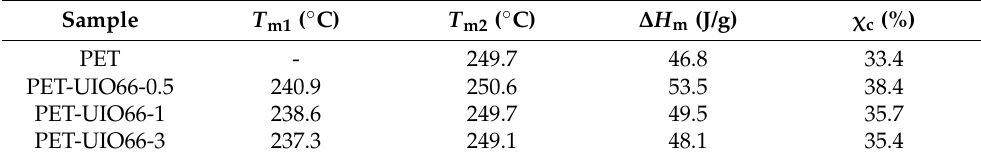
Figure 4. Second heating scans of the PET and the PET/UIO-66 nanocomposites. Table 2. Thermal behaviors of PET and PET/UIO-66 nanocomposites obtained from second heating scan. Sample